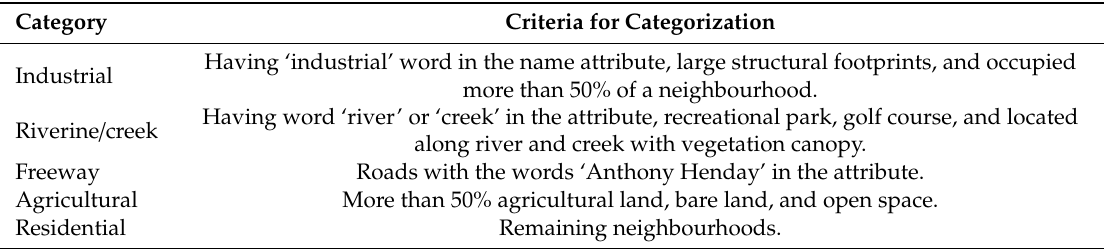
Table 4. Criteria used for grouping the neighbourhoods into five di ff erent categories.